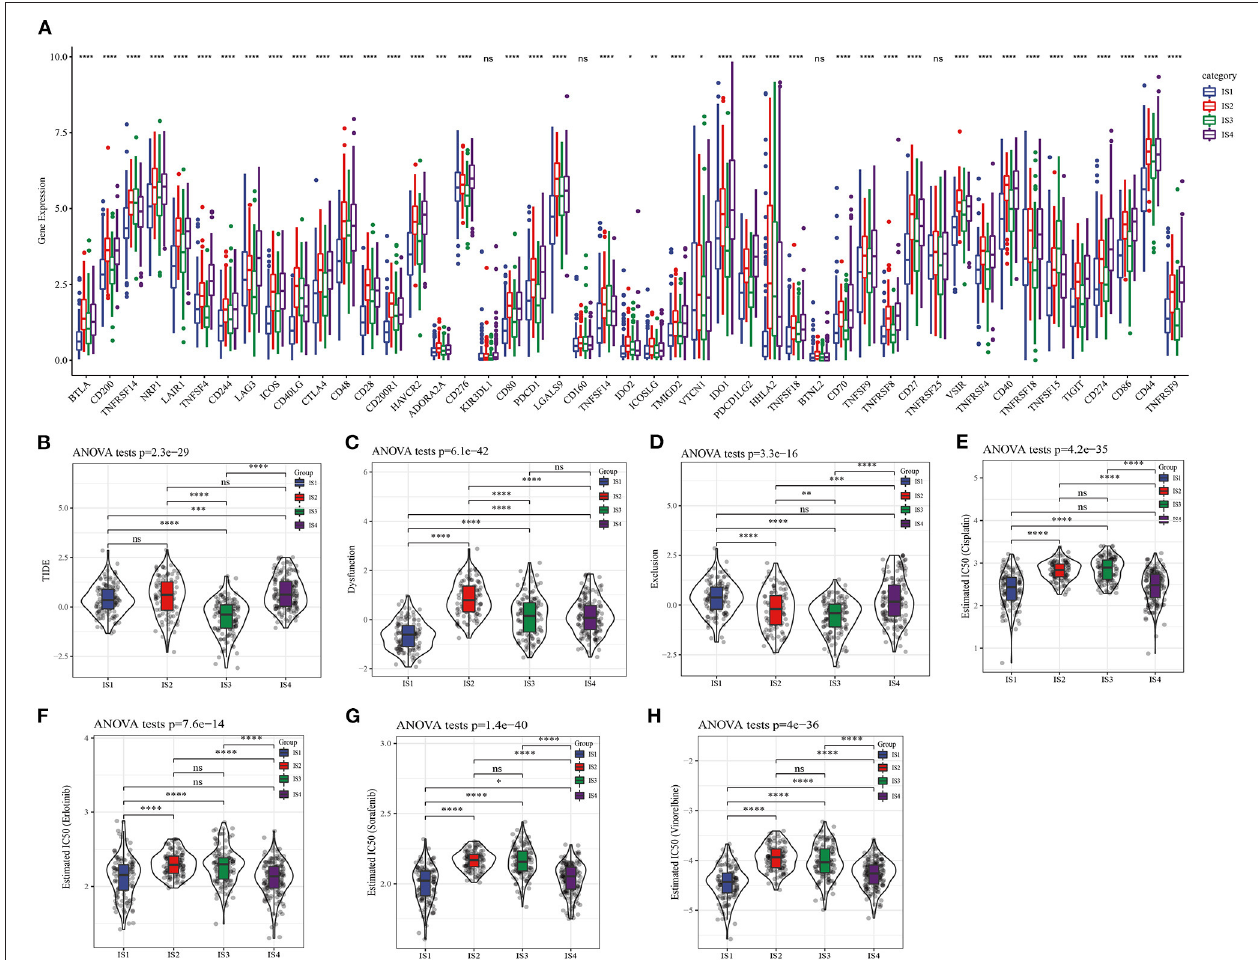
FIGURE 5 | Differential chemotherapeutic and immunotherapeutic responses of ISs. (A) Expression of 47 immune checkpoints in different LUAD subtypes. (B) The TIDE score of different subtypes. (C) T cell dysfunction score of four ISs. (D) T cell exclusion score in four subgroups. (E–H) All the four ISs had significant differences in the estimated cisplatin, erlotinib, sorafenib and vinorelbine IC 50 values.